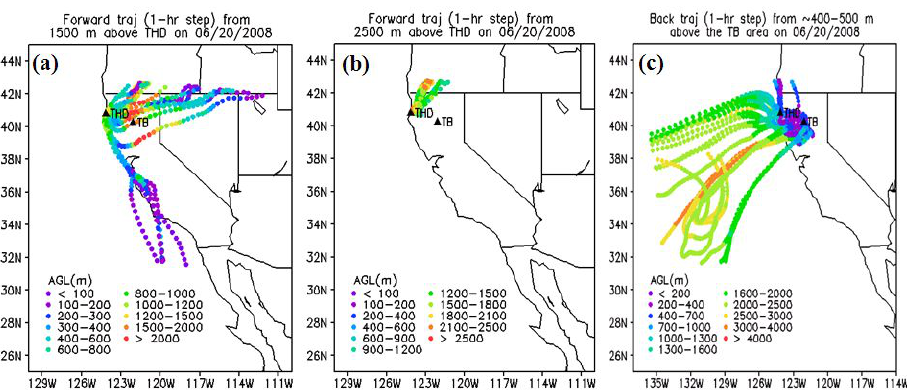
Fig. 11. Forward trajectories originating on 20 June from (a) 1500m (b) 2500m above THD; (c) back trajectories originating from 400– 500m above TB